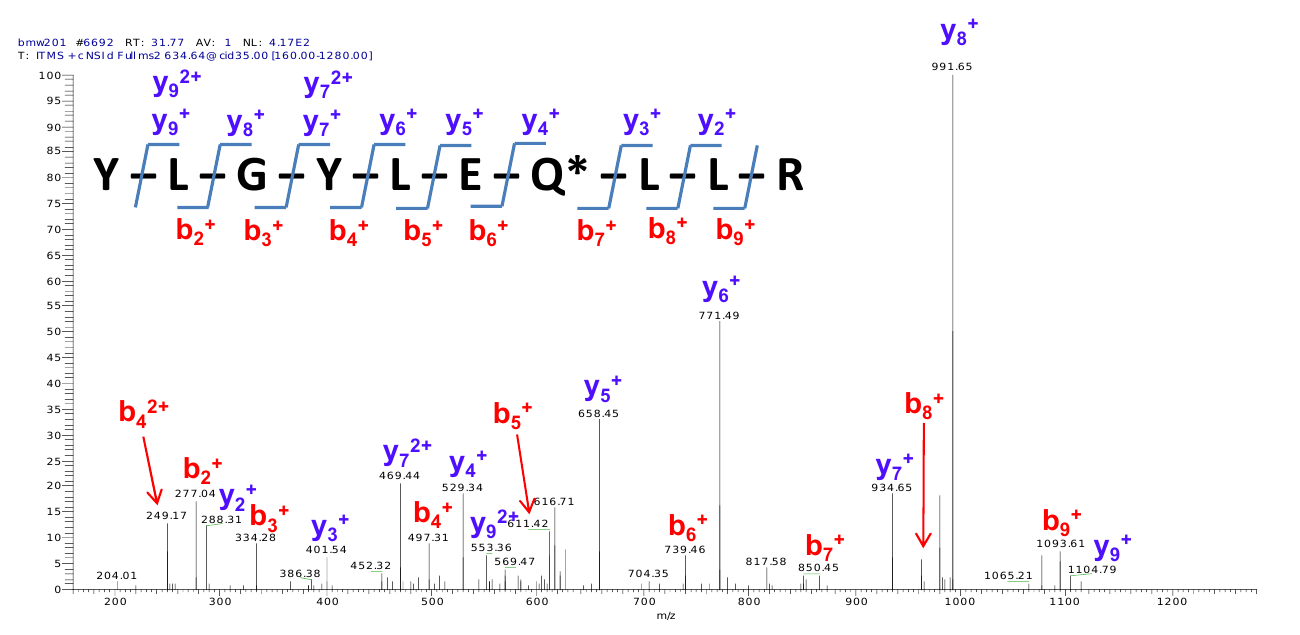
Figure 10. ESI − MS/MS spectrum of the precursor ion peak at m/z 634.6 ( z = 2). In the sequence of YGLYLEQ*LLR, Q* represents Glu (E) modified from Gln (Q) by the deamidation associated with aging.